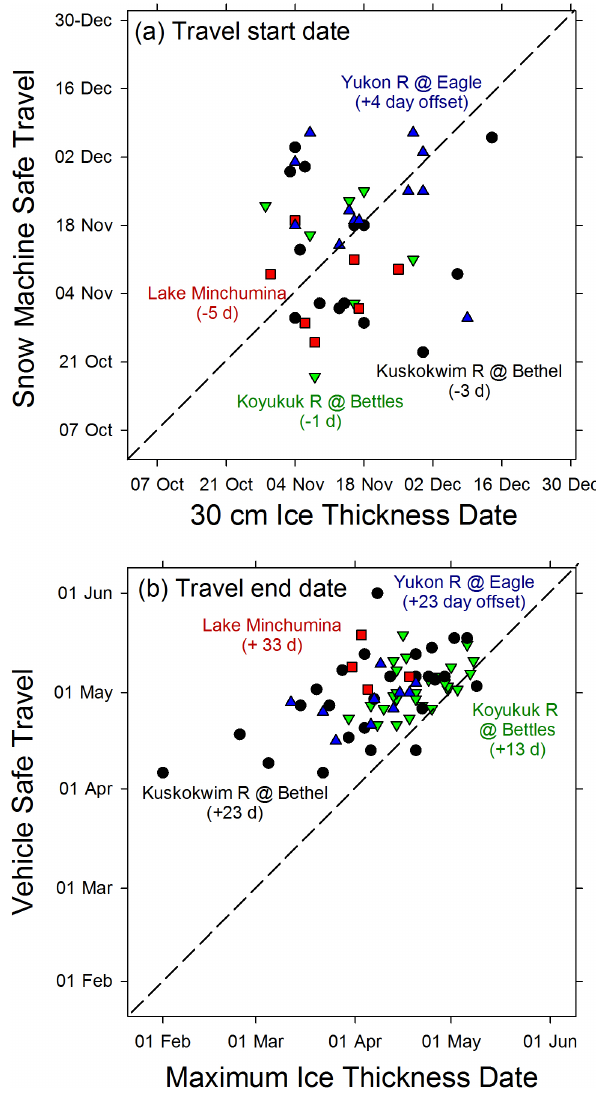
Figure 4. Comparison of ice travel duration metric start (a) and end (b) dates for four study rivers and lakes to ice condition desig- nations reported by Alaska-Pacific River Forecast Center (APRFC)